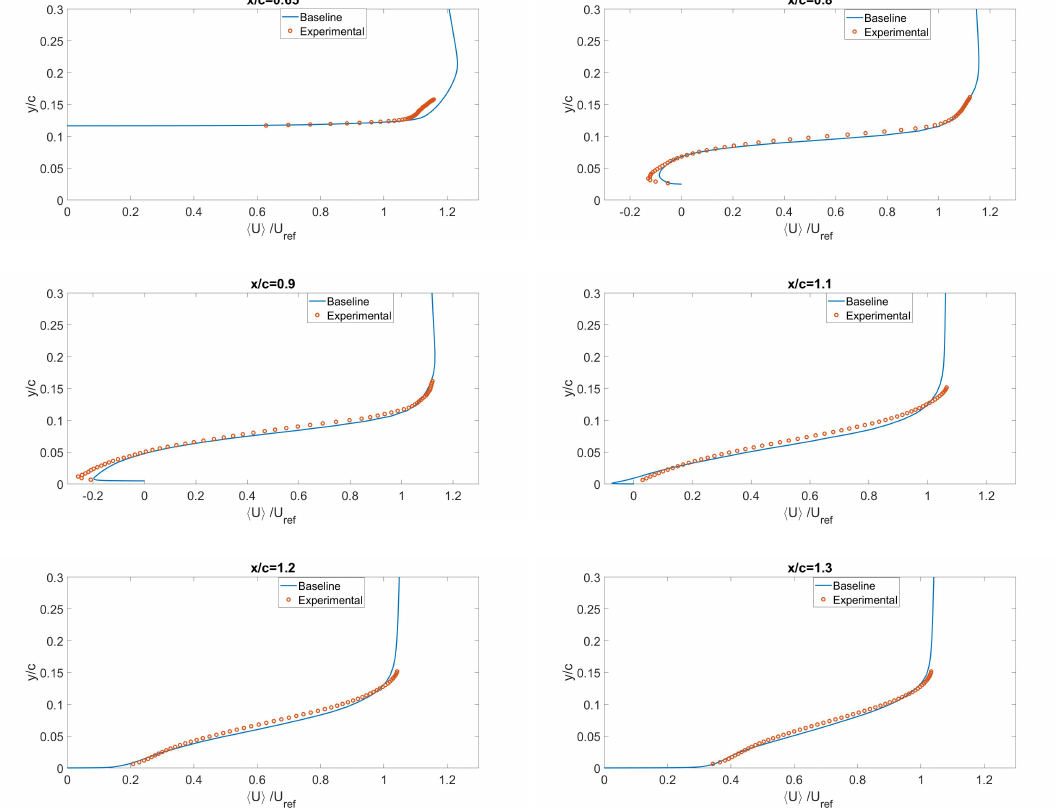
Figure 12. Normalized mean velocity along y / c at different streamwise